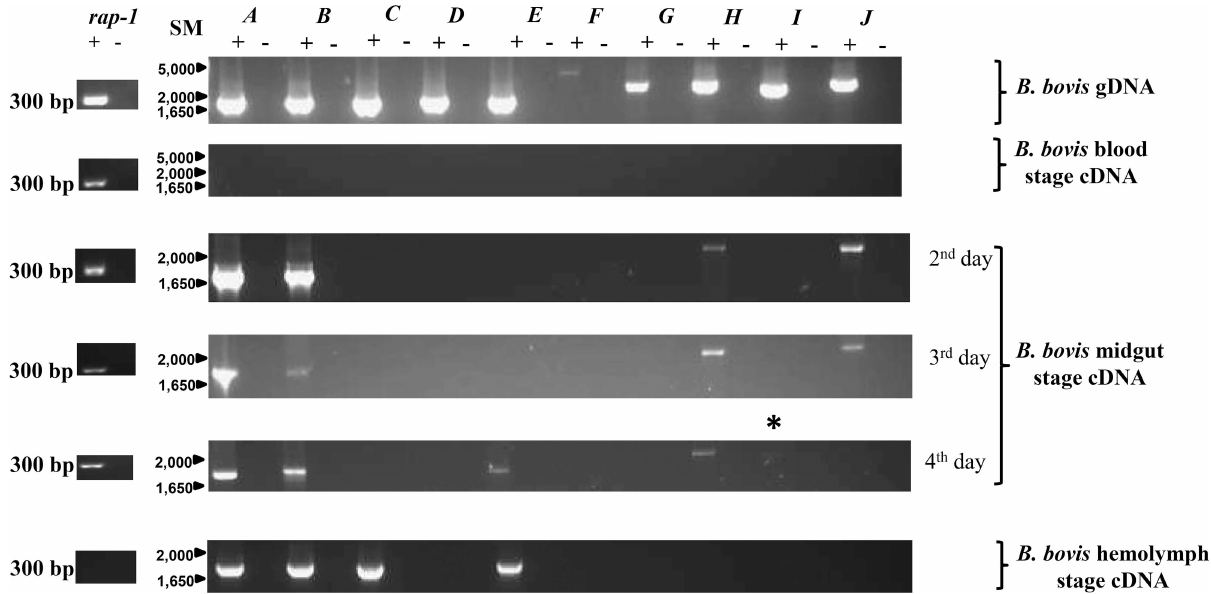
Fig 4. Differential transcription of the Bbo 6-Cys family gene members among three distinct developmental stages of the life cycle of B . bovis . First panel: PCR amplifications of the full ORF of each Bbo 6-Cys family gene members ( A-J ) using gDNA extracted from cultured B . bovis T3bo strain parasites. Amplifications were performed on samples with (+) or without (-) DNA template. PCR amplification of the B . bovis RAP-1 gene was used as a control (left panel). Second panel: Transcription analysisof the Bbo 6-Cys family gene members( A-J ) using cDNA generatedfrom total RNA extracted from in vitro blood culture T3bo strain parasites. Identical results were obtainedusing RNA extracted from in vitro cultured Mo7 clonal line, L17 strain; in vivo T3Bo strain and T strain pair virulent and attenuated (data not shown). Identical amplifications using RAP-1 primers generateda 300 bp PCR product (indicatedin the left panel). Third panel: Transcription analysisof the Bbo 6-Cys family gene members ( A-J ) performed on cDNA generatedfrom total RNA extracted from B . bovis -infected R . microplus midgut. Total RNA was extracted from midguts at different days upon incubation(2, 3 and 4 day) at 28˚C. Asterisk ( * ) indicate presence of faint band for 6-Cys I gene amplification. Amplification of the control rap-1 gene is shown in the left panel. Fourth panel: Transcription analysisof the Bbo 6-Cys family gene members ( A-J ) using cDNA generated from total RNA extracted from B . bovis infected R . microplus hemolymph. Control gene RAP-1 was not amplifiedfrom infected hemolymph. Size markers (SM) are indicated on the left of the large